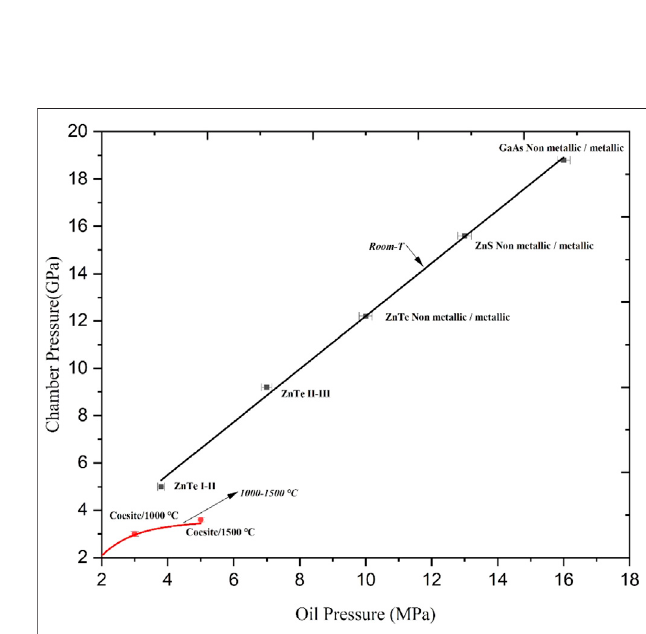
FIGURE4| Pressurecalibrationforthesecond-stage anviloftheDS6× 1400 t 6 – 8 large volume press assembly.